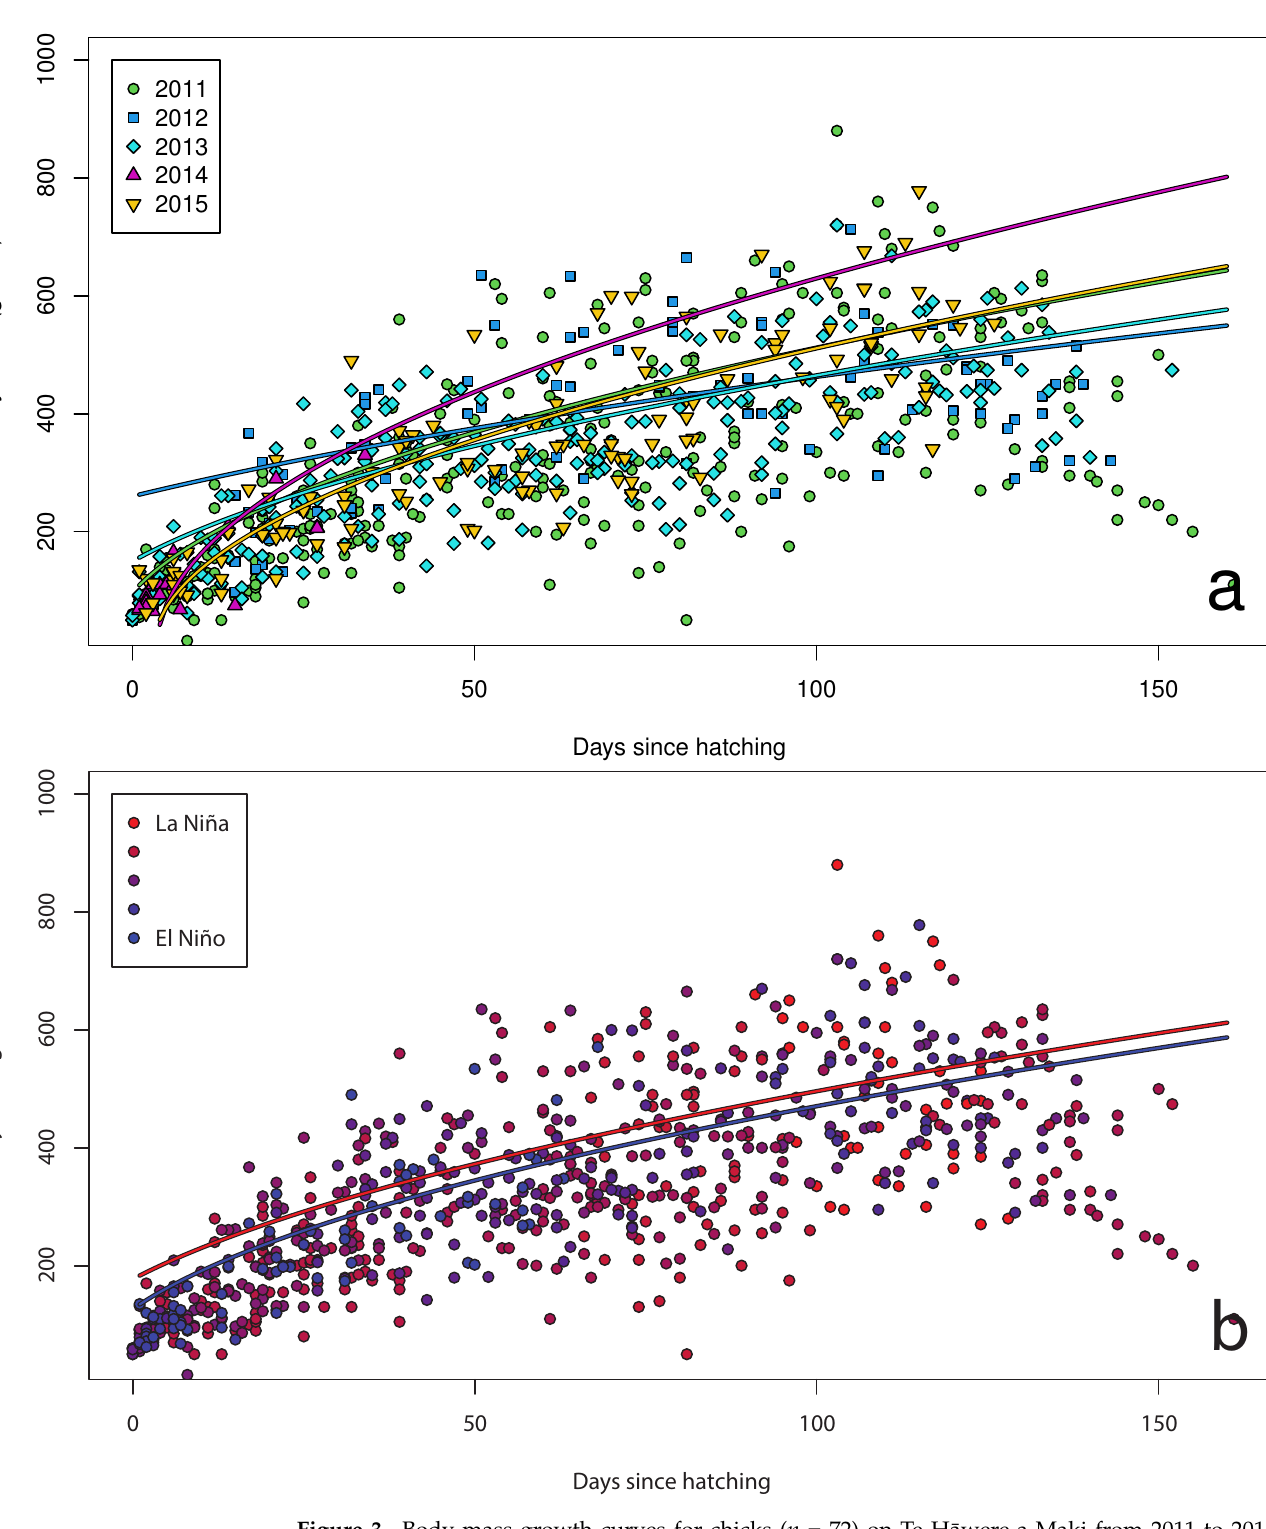
Figure 3. Body mass growth curves for chicks ( n = 72) on Te H¯awere-a-Maki from 2011 to 2015: ( a ) annually; ( b ) monthly Southern Oscillation Index. Lines of best fit indicate years and SOI = –1 or